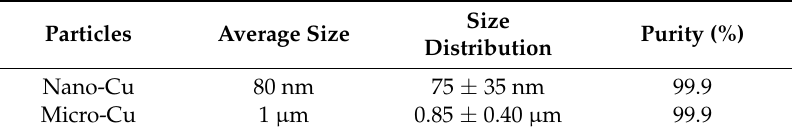
Figure 1. Surface characteristics of nano-copper: 1- µ m copper particles ( A ) and Nano Cu particles ( B ). The average particle size of 1- µ m copper particles and nano-copper particles is about 1 µ m and 80–100 nm, respectively. Table 1. Physical and chemical parameters of 1 µ m Cu and nano-Cu.